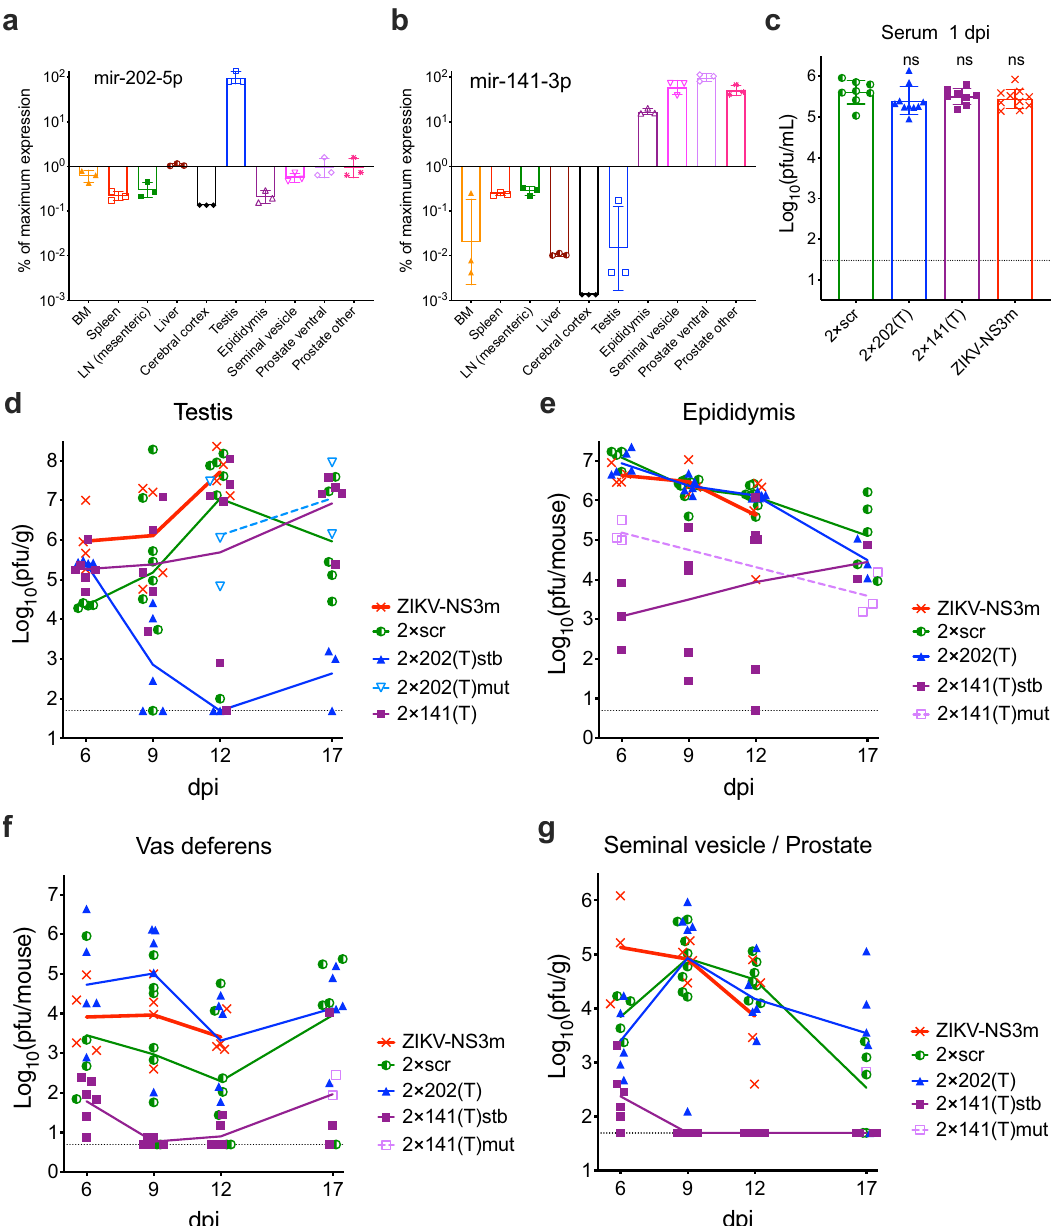
Fig. 1 Effect of miRNA target insertion on ZIKV replication in the MRS organs of adult AG129 mice. Relative expression of the mir-202 ( a ) and mir-141 ( b ) in the selected rodent organs based on published miRNA array data 40 . Plotted are the ratios of signal intensity for each miRNA in indicated organs ( n = 3) normalized to the signal intensity in the testis ( a ) or ventral prostate ( b ) (the organs with a highest expression of corresponding miRNAs). BM bone marrow, LN lymph node. Data are presented as geomegtic mean values ± geomegtic standard deviation. ( c – g ) Adult male AG129 mice were infected IP with 10 6 pfu of ZIKV-NS3m, 2 × scr, 2 × 202(T), or 2 × 141(T) virus. Replication kinetics of indicated viruses in the serum ( c ) and components of the MRS ( d – g ). Viruses with stable miRNA-target sequences are indicated as stable (stb). Viruses with deletions or point mutations in the miRNA-target sequences are indicated as mutant (mut). If all virus samples from the organ remained stable, no additional notations were made to the virus name. c Data are presented as mean titer ± SD. Differences between the titer of 2 × scr ( n = 8) and the titer of 2 × 202(T) ( n = 10), 2 × 141(T) ( n = 8), and ZIKV-NS3m ( n = 10) in mouse serum at 1 dpi were compared using one-way ANOVA with multiple comparison adjustment. p values (from left to right): ns, p = 0.279; ns, p = 0.774; ns, p = 0.453. d – g Data show each replicates (the virus titer in the organ dissected from an individual mouse) and mean virus titers (connecting lines). The limit of detection (dashed lines): 1.5 log 10 (pfu/mL) for serum, 1.7 log 10 (pfu/g) for testis and SV/P, and 0.7 log 10 (pfu/mouse) for epididymis and vas deferens. compared to 2 × scr. In contrast, accumulation of 2 × 202(T) in independently of the testicular infection 22 . The titer of 2 × 141(T) the epididymis of mice was comparable to that of 2 × scr, and 2 × stb in the epididymis was lowest at 6 dpi, but gradually increased 202(T) escape mutants were not detected in this organ. These from 9 to 17 dpi. Importantly, escape mutants of the 2 × 141(T) results support the previous fi ndings suggesting that ZIKV virus [2 × 141(T)mut in Fig. 1e] were detected only in the infection of the epididymis can occur via a hematogenous route epididymis, but not in the testis of infected mice. The highest level NATURE COMMUNICATIONS| (2021) 12:2469